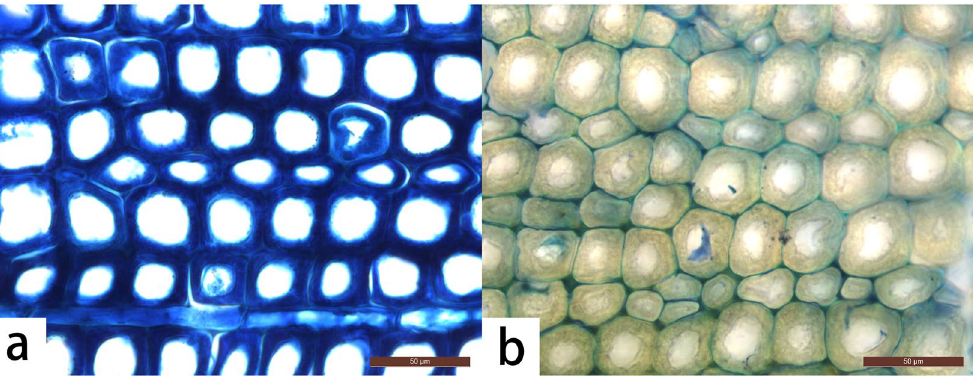
Figure 4. Optical micrographs of ( a ) untreated archaeological wood and ( b ) PBMA grafted archaeological wood, scale bar: 50 μ